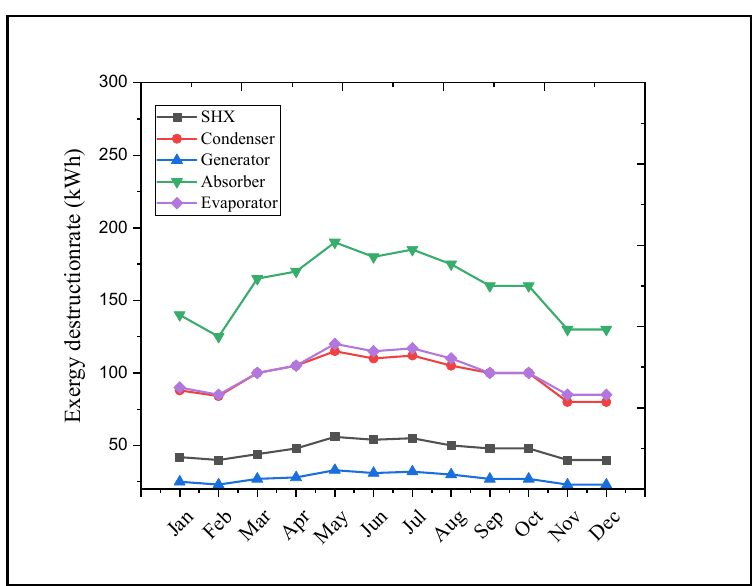
Figure 9. The exergy level of the Sigel single-effect lithium-bromide absorption cooling components for the months of the year.